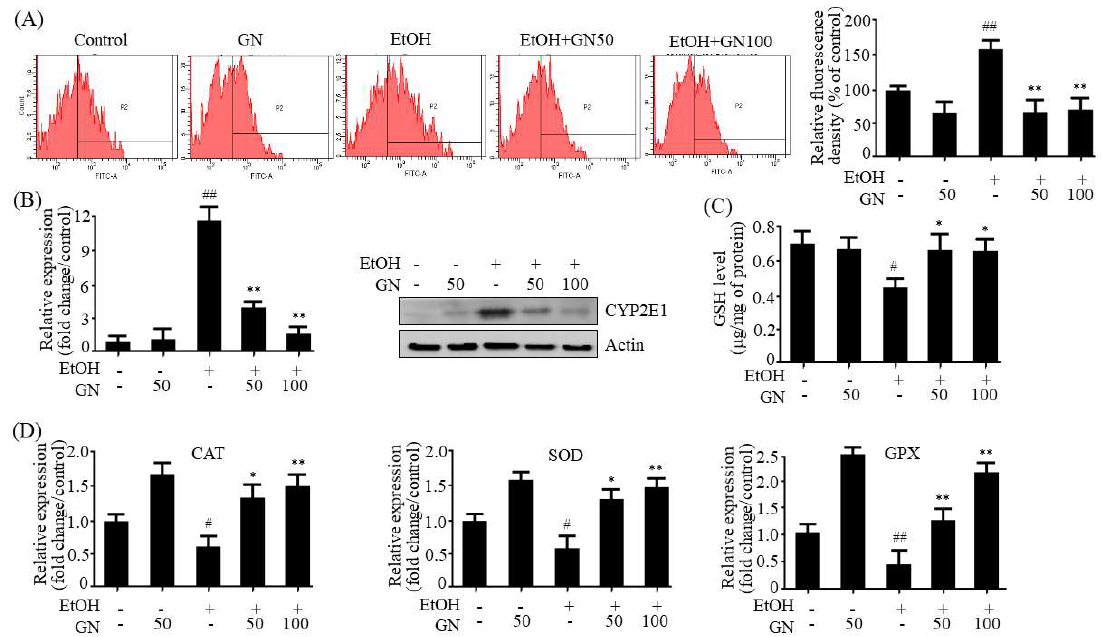
Figure 7. Gomisin N inhibits ethanol-induced oxidative stress in HepG2 cells. HepG2 cells were treated with 50 mM ethanol in the presence or absence of GN (50 or 100 μM) for 24 h. ( A ) 2,7-dichlorofluorescein diacetate (DCFH-DA) analysis of reactive oxygen species (ROS). ( B ) qPCR and western analysis of h CYP2E1 . ( C ) Measurement of intracellular GSH levels. ( D ) qPCR analysis of h CAT , h SOD , and h GPX . Values are the mean ± SD of triplicate experiments. # p < 0.05, ## p < 0.01 vs. untreated control, * p < 0.05, ** p < 0.01 vs. ethanol-treated group.